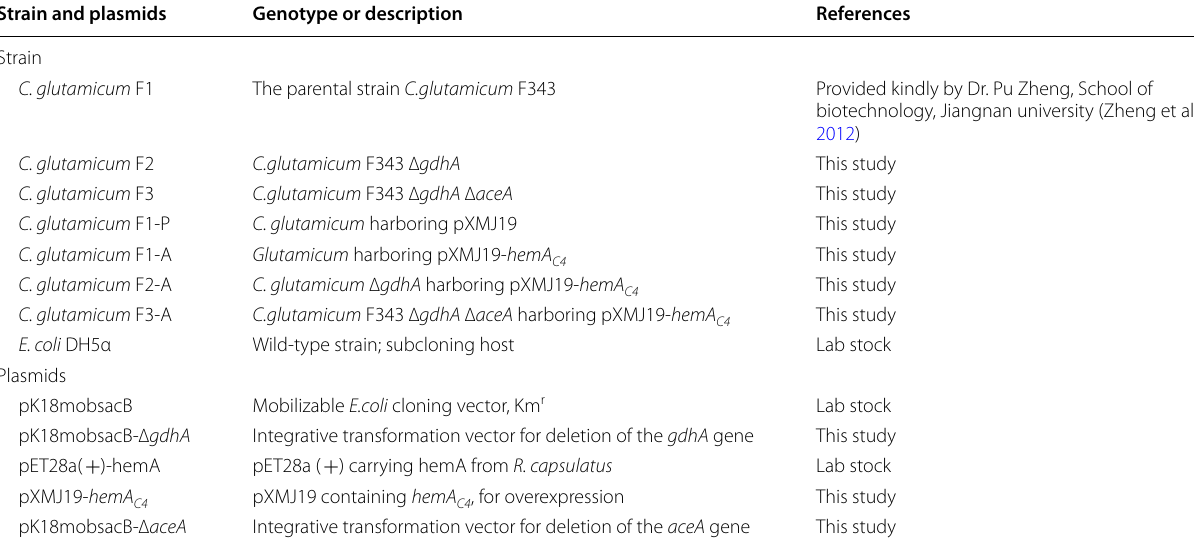
Table 1 List of strains and plasmids used in this study Strain and plasmids Genotype or